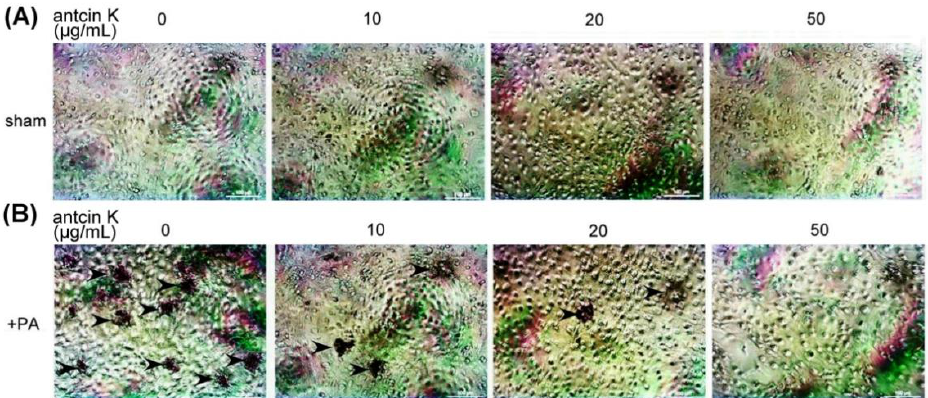
Figure 8. Antcin K treatments effectively decreased the lipid deposition in palm acid oil-treated vascular endothelial cells. Vascular endothelial cells with ( A ) sham and ( B ) palm acid oil (PA) treatments. Cellular lipid depositions were shown by oil red O staining (indicated by the arrow).